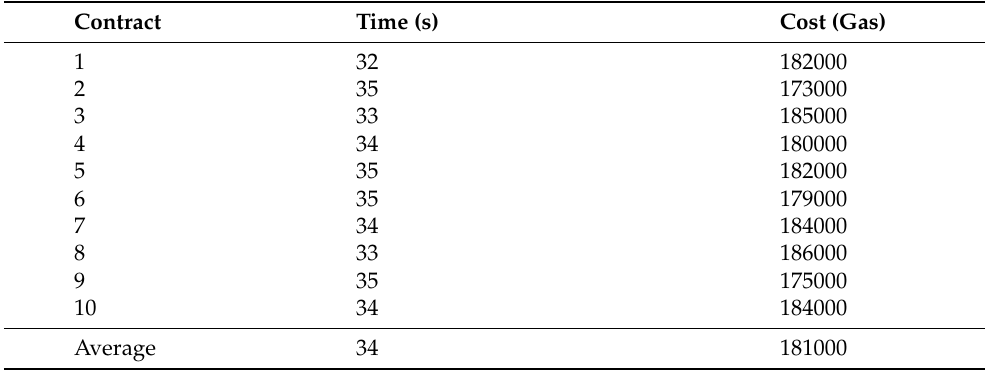
Table 2. Voter registration: The average contract deployment time for 10 contracts, where the average computed for 30 experiments is given and the cost of gas is reported. The average time for deployment over all trials is 34 s and the associated average cost is 181000.